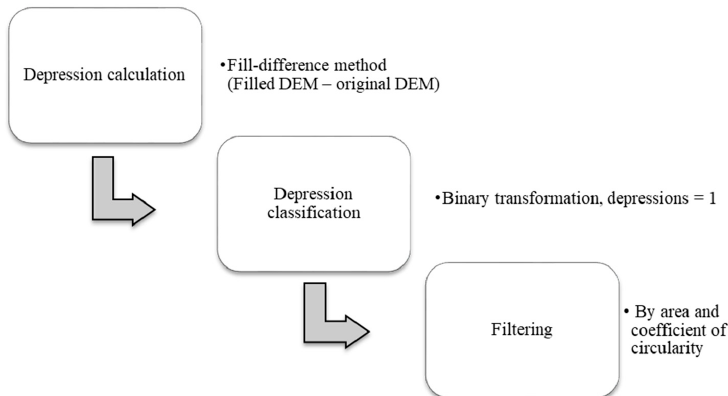
Figure 1. Basic workflow to estimate karst depressions. A depth threshold is commonly applied as a parameter of the Fill algorithm [1,24] or near surface to eliminate shallow dolines. DEM refers to digital elevation model.